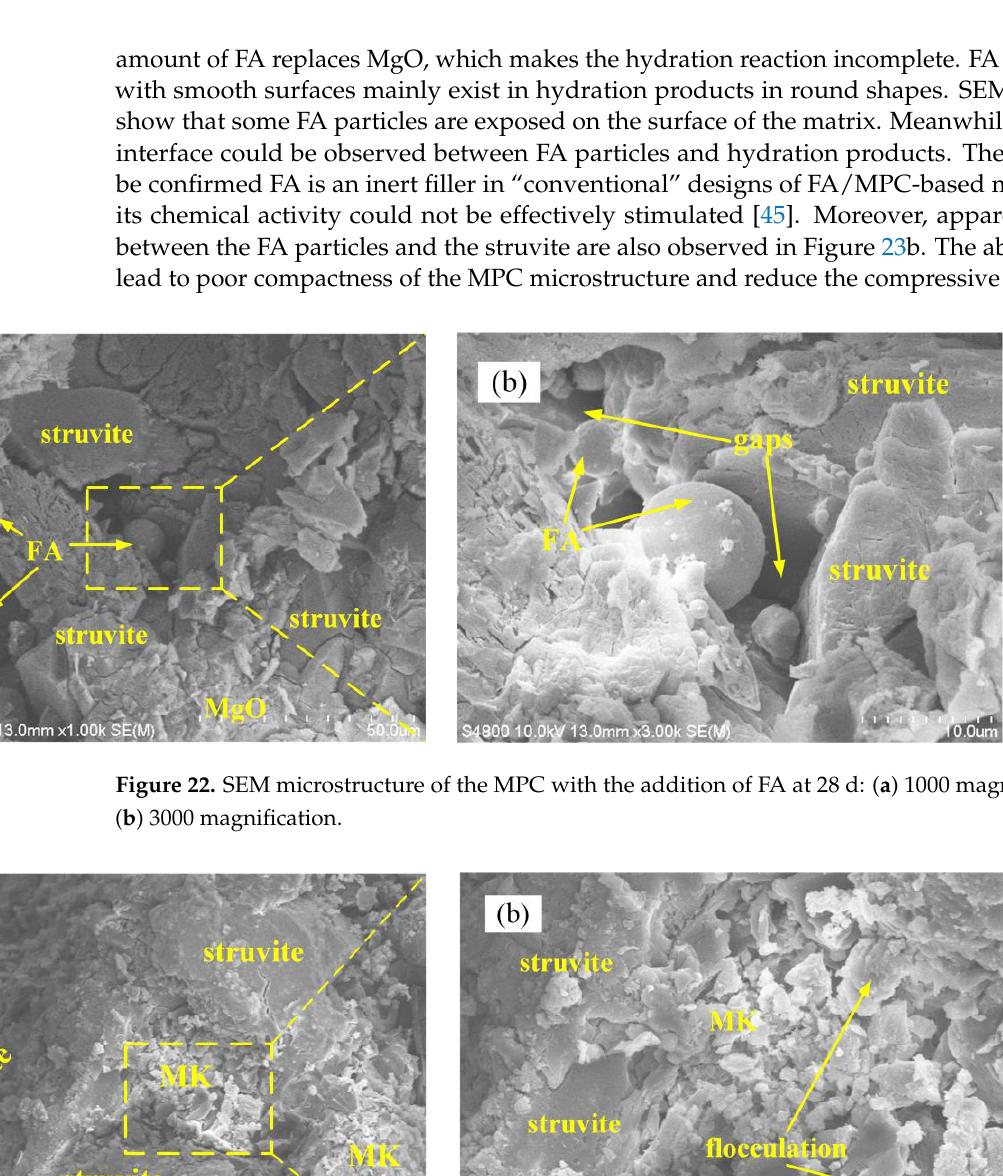
Figure 21. SEM microstructure of MPC at 28 d: ( a ) 1000 magnification, ( b ) 3000 magnification.